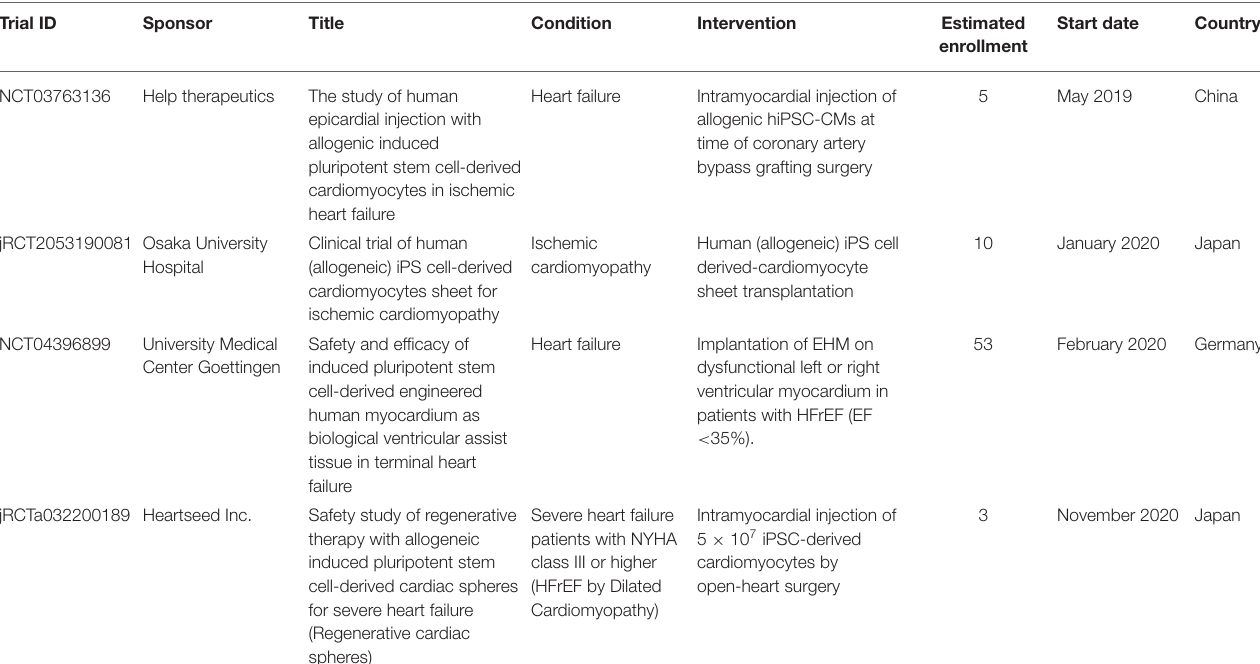
TABLE 1 | Current clinical trials involving hPSC-CM transplantation for heart repair. Trial